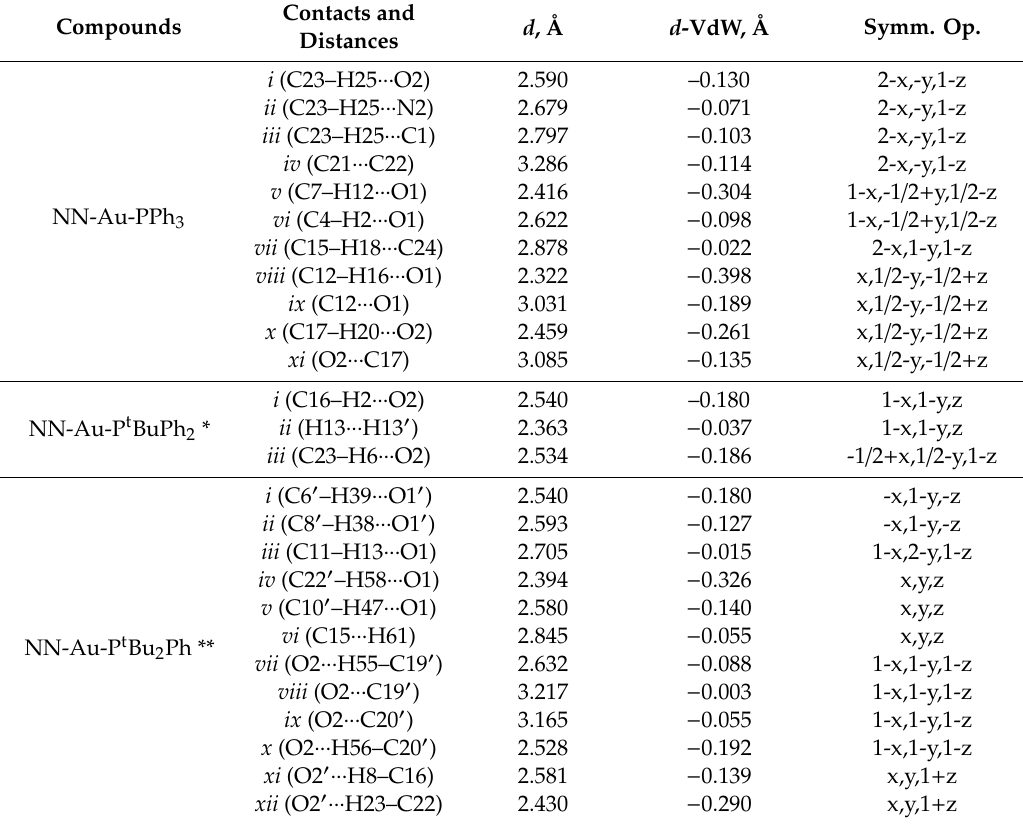
Table 2. The parameters of short contacts and interatomic distances for NN-Au-PPh 3 [4], NN-Au-P t BuPh 2 ( 1 ), and NN-Au-P t Bu 2 Ph ( 2 ). C (cid:48) corresponds to an analogous carbon atom in another independent structure of NN-Au-P t Bu 2 Ph.